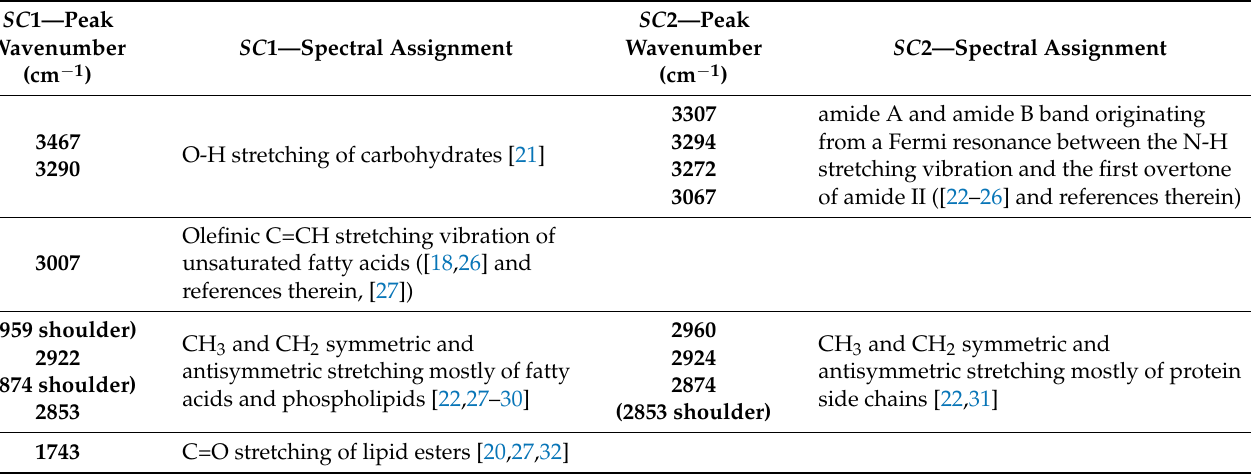
Table 2. Band assignments of the two spectral components, SC 1 and SC 2, obtained from the MCR decomposition of the ATR-FTIR